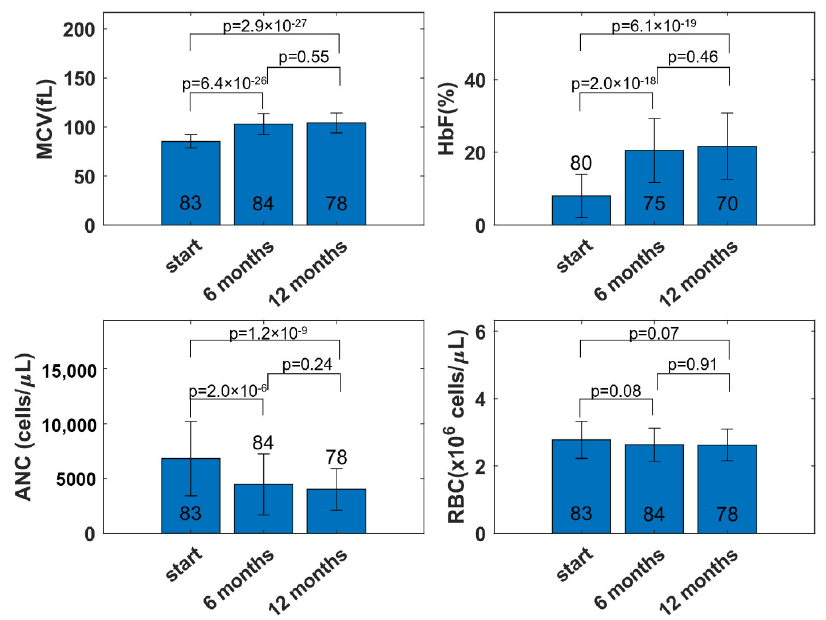
Figure 2. Trends in clinical variables averaged across participants at the start and following 6 months and 12 months of hydroxyurea treatment. The bar plot represents the mean; the error bar represents the standard deviation of the clinical variables; the number on the bar plot represents the number of individuals. MCV, mean cell volume; HbF, fetal hemoglobin; RBC, red blood cell; ANC, absolute neutrophil count.